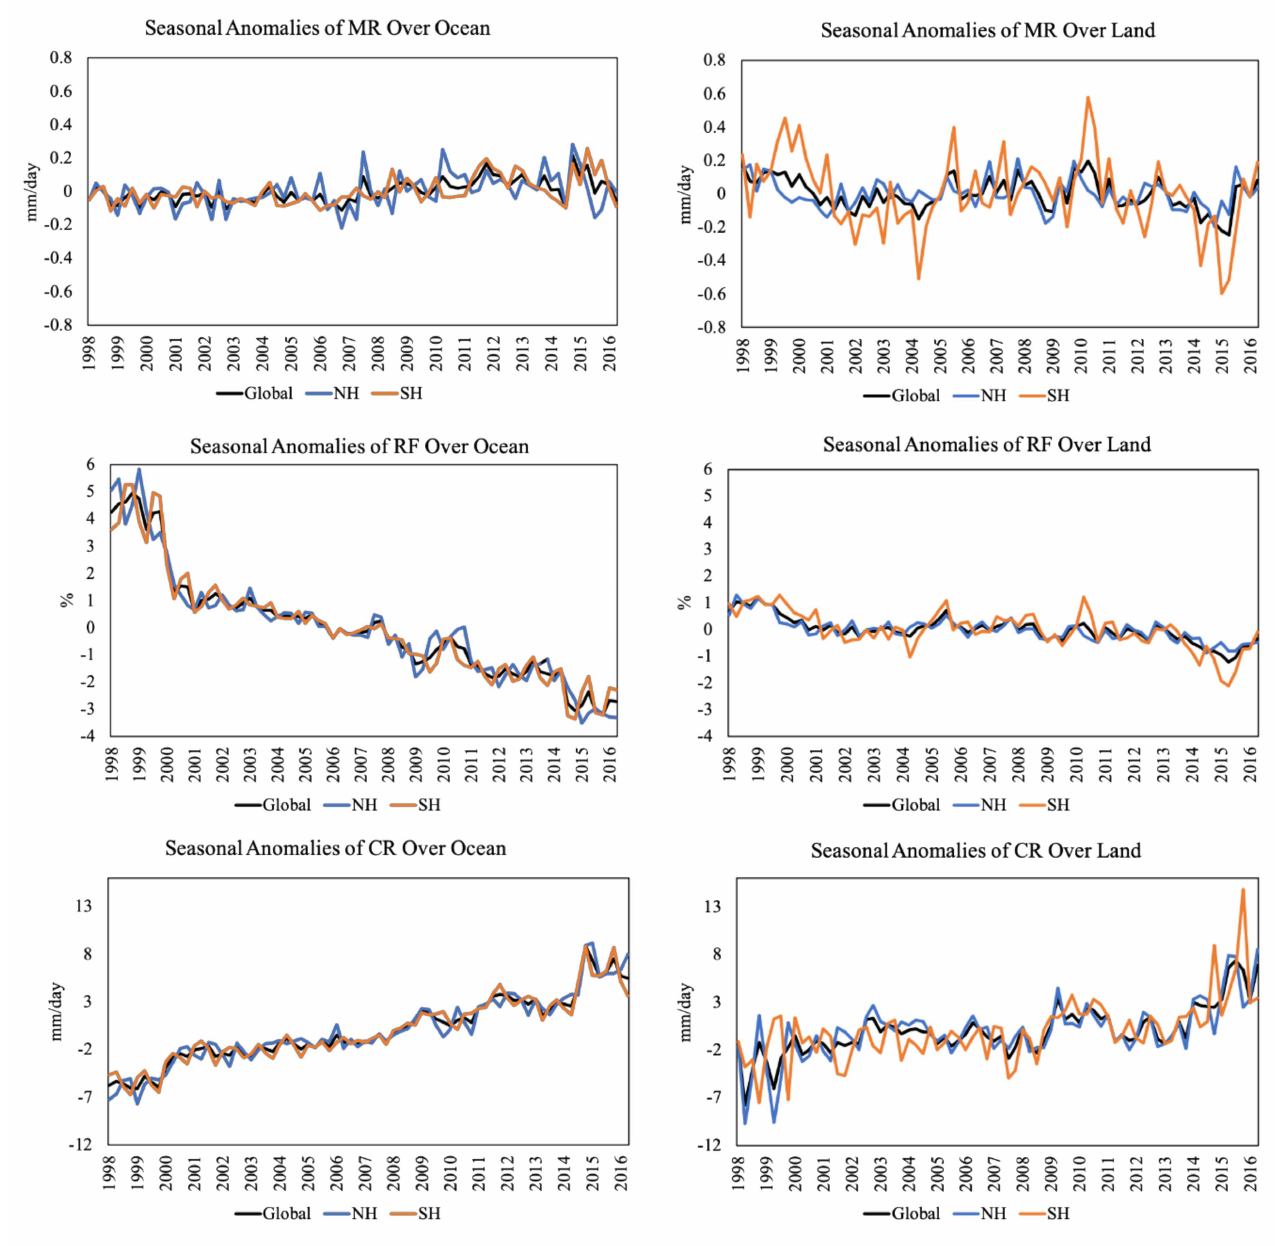
Figure 3. Anomalies of mean precipitation rate (MR), precipitation frequency (RF) and precipitation intensity (CR) for Ocean ( left ) and Land ( right ) in global, northern and southern hemisphere